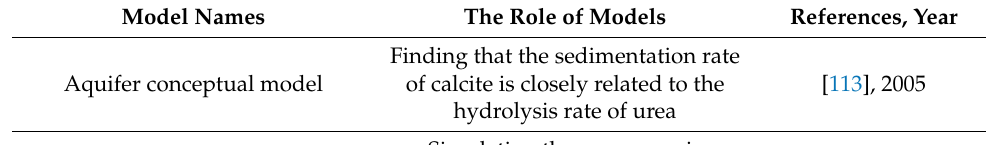
Table 4. Models for predicting the curing process of